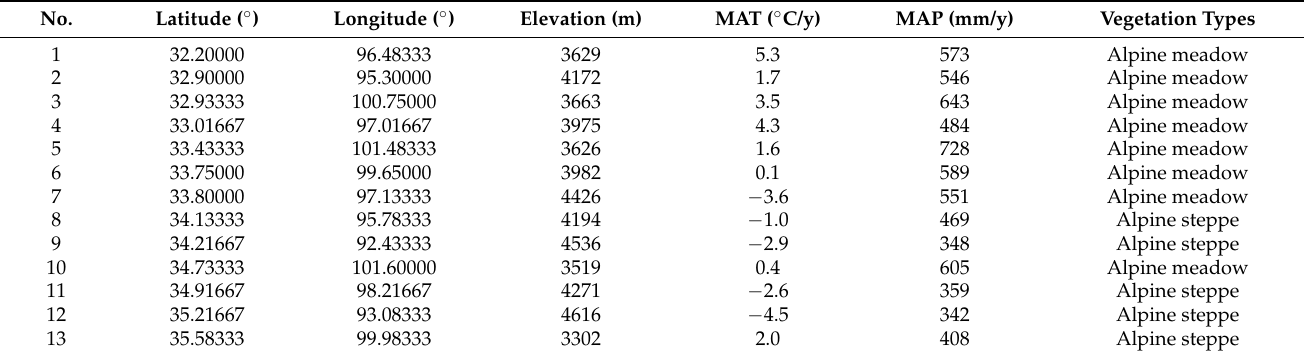
Table 1. The characteristics of the meteorological stations in the Three-River Source Region (TRSR).